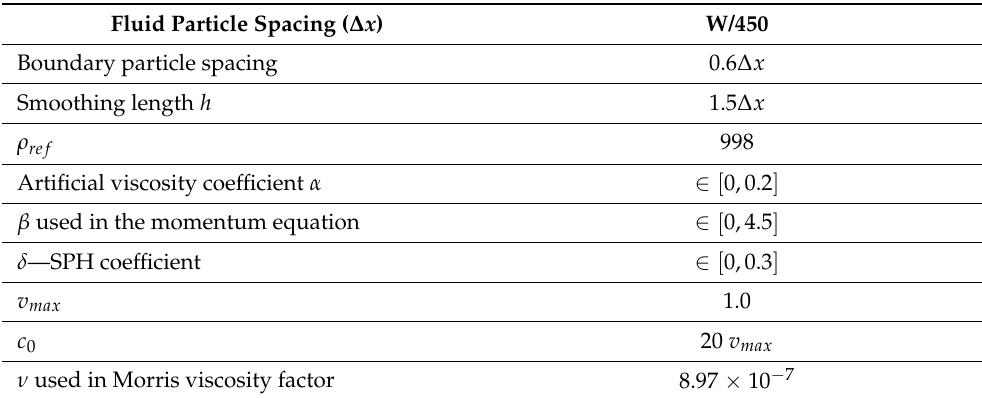
Table 2. Parameters and the numerical setting used in the sloshing